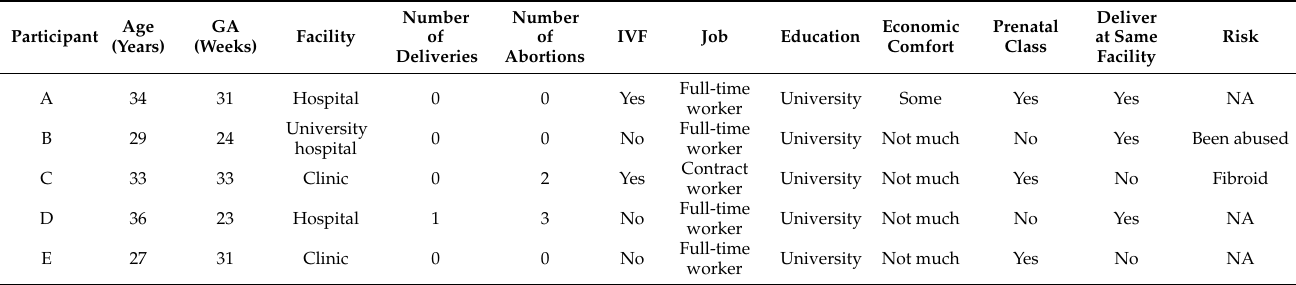
Table 1. Participants’